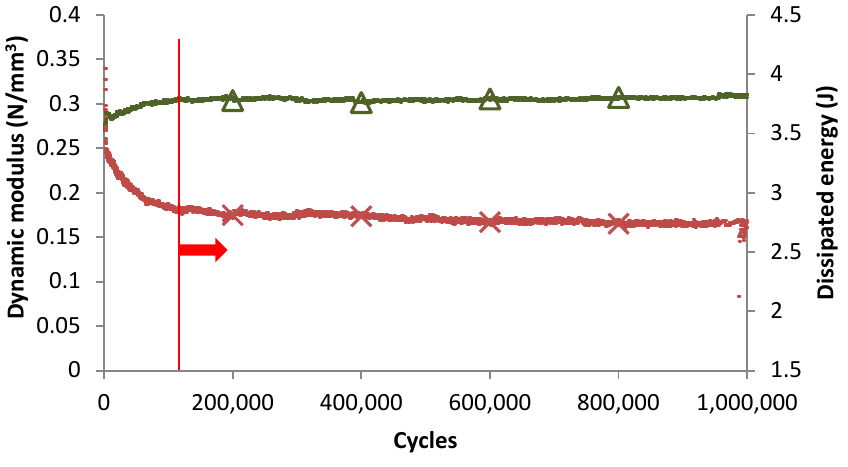
Figure 8. Evolution of dynamic modulus and dissipated energy values during tire USP fatigue